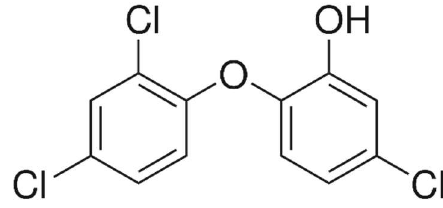
Figure 1. Structure of triclosan.